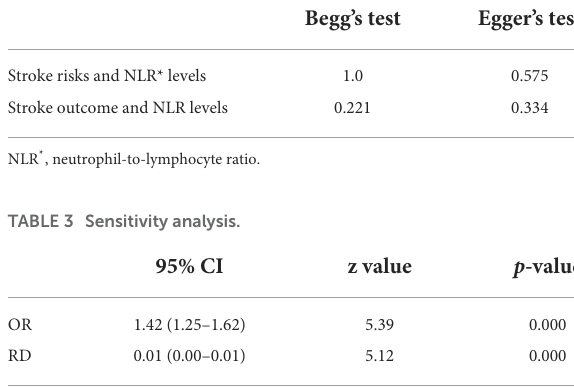
TABLE 2 Result of publication bias.